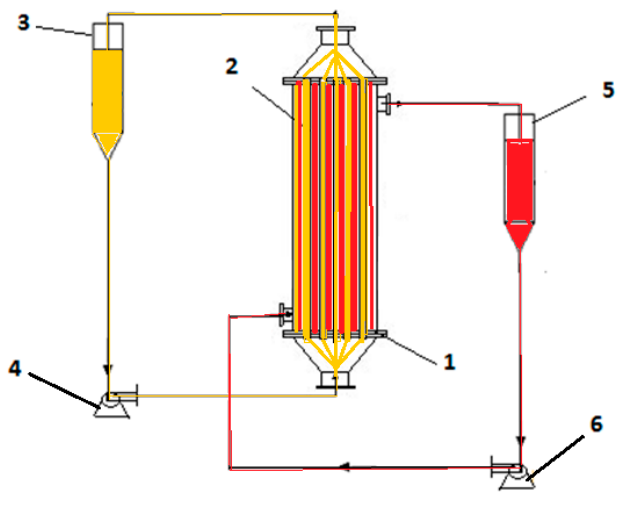
Figure 1. Installation used for the osmium nanoparticles–polymer composite membranes (Os np –